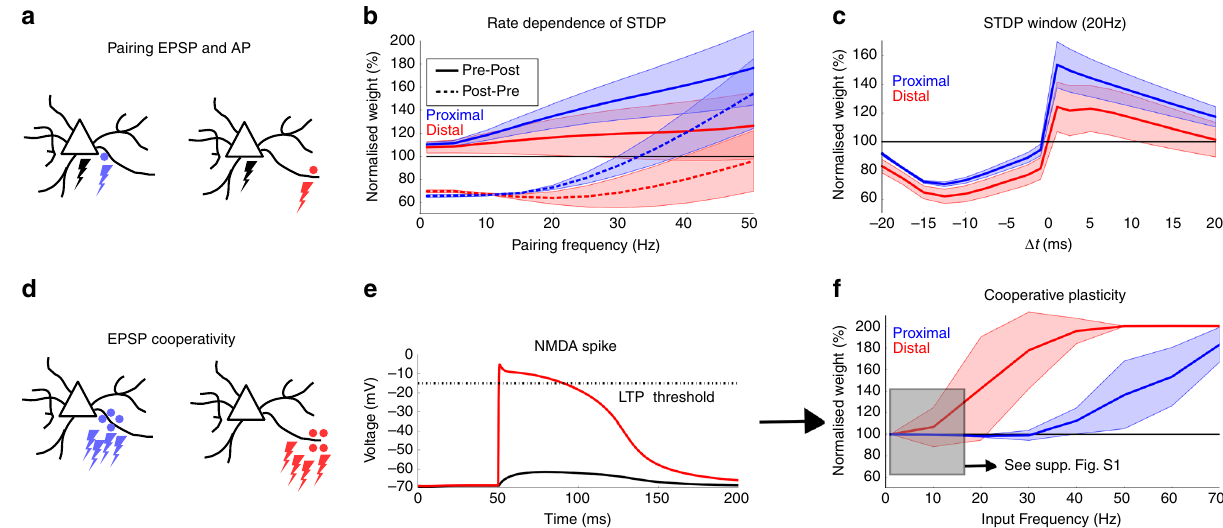
Fig. 2 Plasticity gradient along basal dendrites. a Action potentials ( black lightning ) are paired with either proximal ( blue ) or distal ( red ) synaptic activations. b The pairing protocol as in Sjöström et al. 23 is simulated. Action potentials and EPSPs are paired with a fi xed interval of 10 ms, either pre – post ( full lines ) or post – pre ( dashed lines ). Five pairings at a fi xed frequency are repeated 15 times (Methods section). The protocol is repeated for several pairing frequencies ( horizontal axis ) and the weight is displayed normalised to the initial value ( vertical axis ). The plasticity parameters were chosen to qualitatively reproduce the experimentally observed rate-dependence. Distal synapses show less potentiation due to the attenuation of the bAP. The solid lines are the means over all proximal ( blue ) or distal ( red ) compartments shown in Fig. 1a, the shaded regions are one s.d. c The same protocol as in b is repeated at a pairing frequency of 20 Hz, but the interspike interval is now varied ( horizontal axis ). The weight is normalised to the initial value ( vertical axis ) and shows the standard STDP window, where the potentiation at distal synapses is reduced compared to proximal synapses due to the attenuation of the bAP. The solid lines are the means over all proximal ( blue ) or distal ( red ) compartments shown in Fig. 1a, the shaded regions are one s.d. d A group of synapses on a proximal compartment ( blue ) or distal compartment ( red ) are activated by a Poisson process. e Distal groups of synapses can elicit NMDA spikes ( red trace ), which cross the LTP threshold of the plasticity model and can therefore result in potentiation while remaining sub-threshold in the soma ( black trace ). f When activating the synaptic groups as described in d , LTP is observed at much lower average activation rates for the distal group ( red trace ) compared to the proximal group ( blue trace ). This dLTP compensates for the lack of potentiation by STDP b , c . The solid lines are the means over all proximal ( blue ) or distal ( red ) compartments shown in Fig. 1a, the shaded regions are one s.d. Supplementary Fig. 1 shows distal depression at low rates ( black shaded region ) more